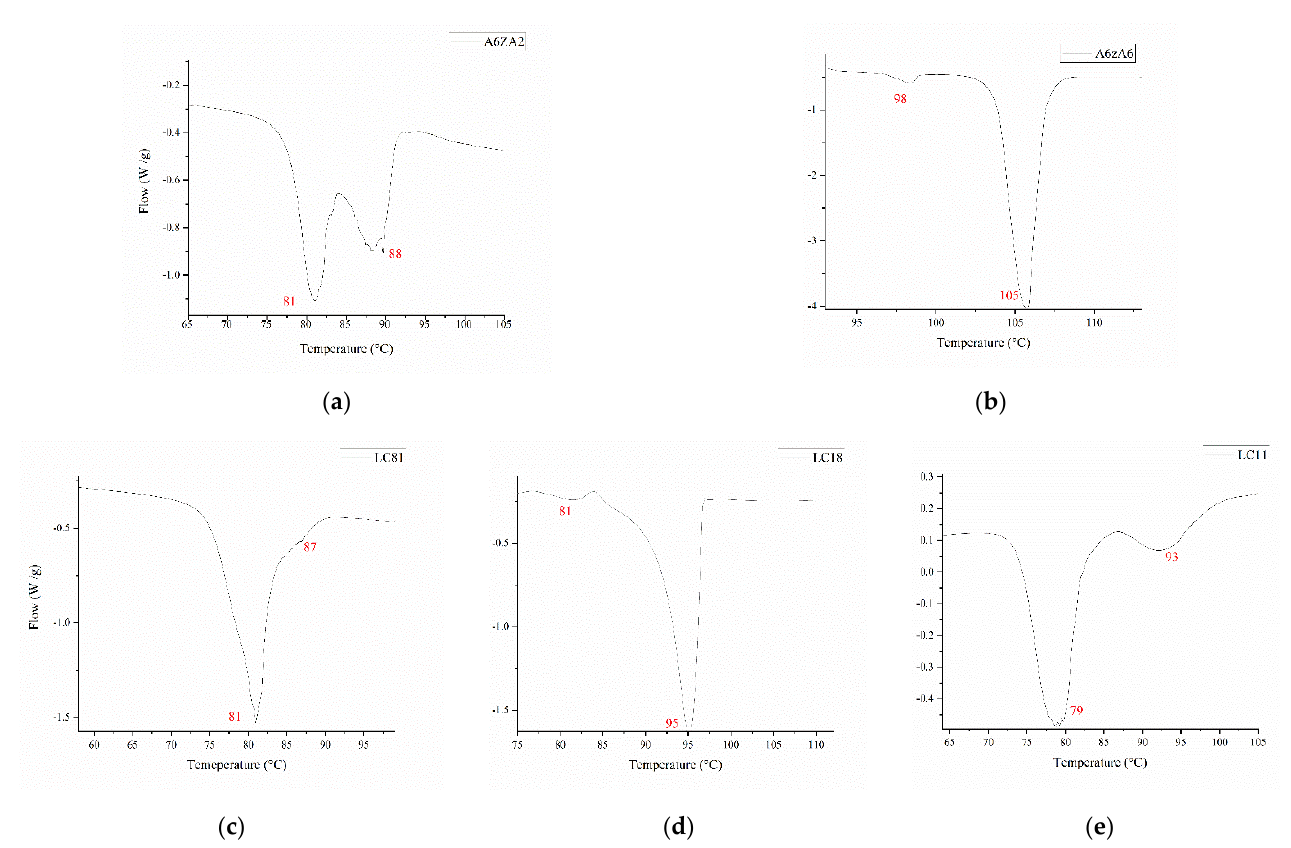
Figure 1. Melting profiles of LCs employed: ( a , b ) show the melting profile of A6zA2 and A6zA6, respectively, these are the monomer LCs used for the mixtures. ( c ) Melting profile of LC81 that does not show any nematic range, possibly because it is covered by the isotropic temperature. ( d ) Melting profile of LC18: in this case, again the isotropic temperature covers the nematic range. ( e ) Melting profile of LC11: in this case, it is possible to see the nematic phase between the two melting temperatures, indicating a range centered around 84 °C.